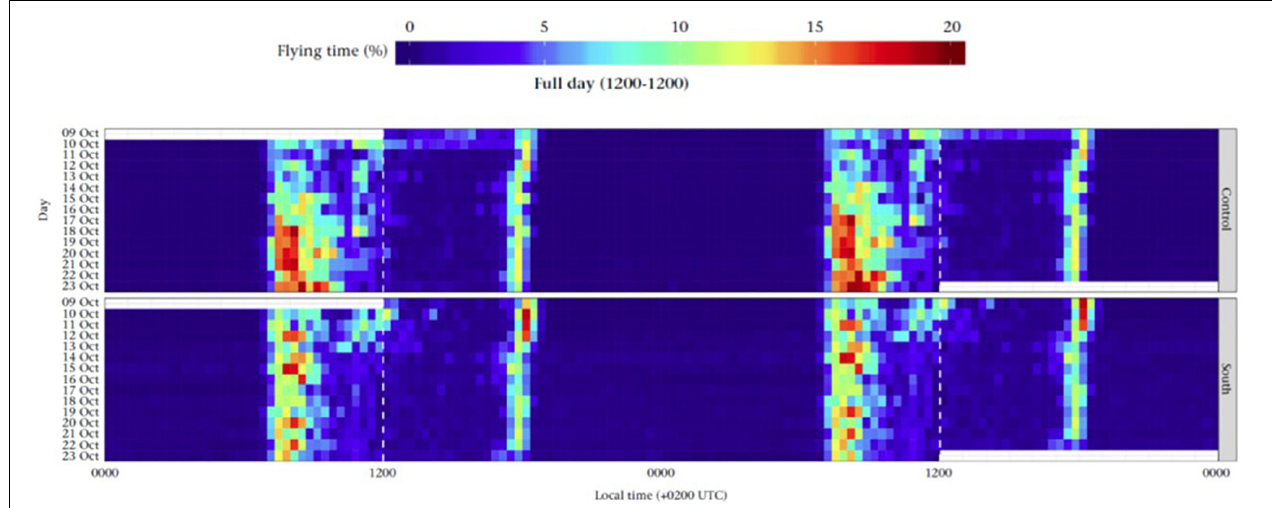
FIGURE 6 | Effects of geomagnetic cues on Zugunruhe. Actograms for first-year migratory Dunnocks monitored from 9 to 24 October 2015 under the local geomagnetic condition (control, top ) and under simulated geomagnetic conditions (south displacements, bottom ). Each horizontal line shows the mean time spent in flying mode by eight birds per group; days are duplicated for easier viewing as in Figure 5 (except for first and last half-days). Dashed vertical lines indicate 12.00 h local time (14.00 UTC), that is, the time when geomagnetic displacements took place during the first 5 days of the experiment. Figure modified after Ilieva et al. (2018). Actogram reproduced with kind permission from Animal Behaviour